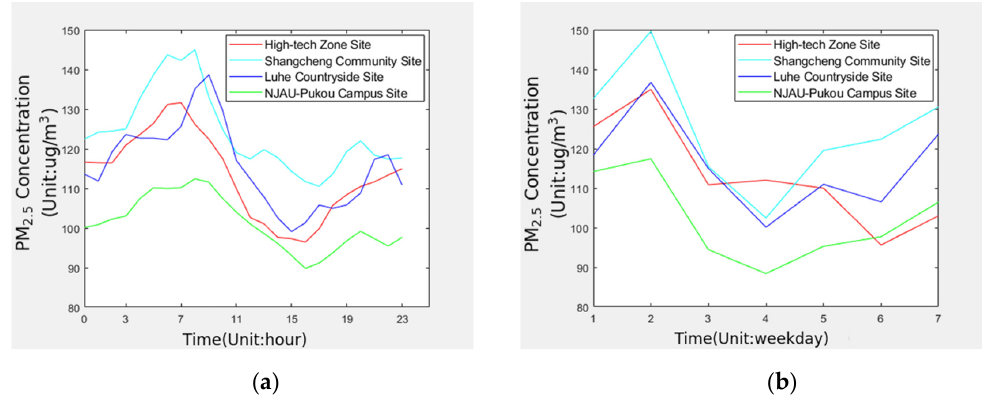
Figure 4. The resulting line figures of averaging the preprocessed data using MATLAB software: ( a ) PM 2.5 hourly average concentration change line; ( b ) PM 2.5 daily average concentration change line.